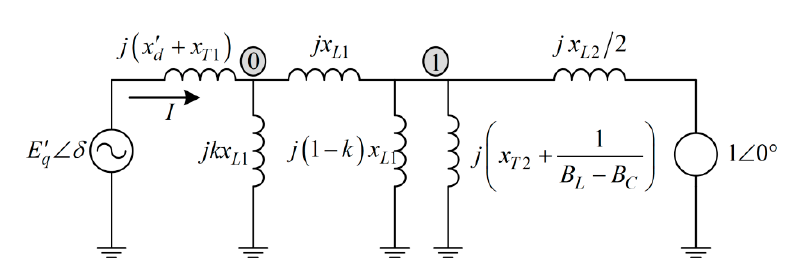
Figure 3. Equivalent circuit during fault.